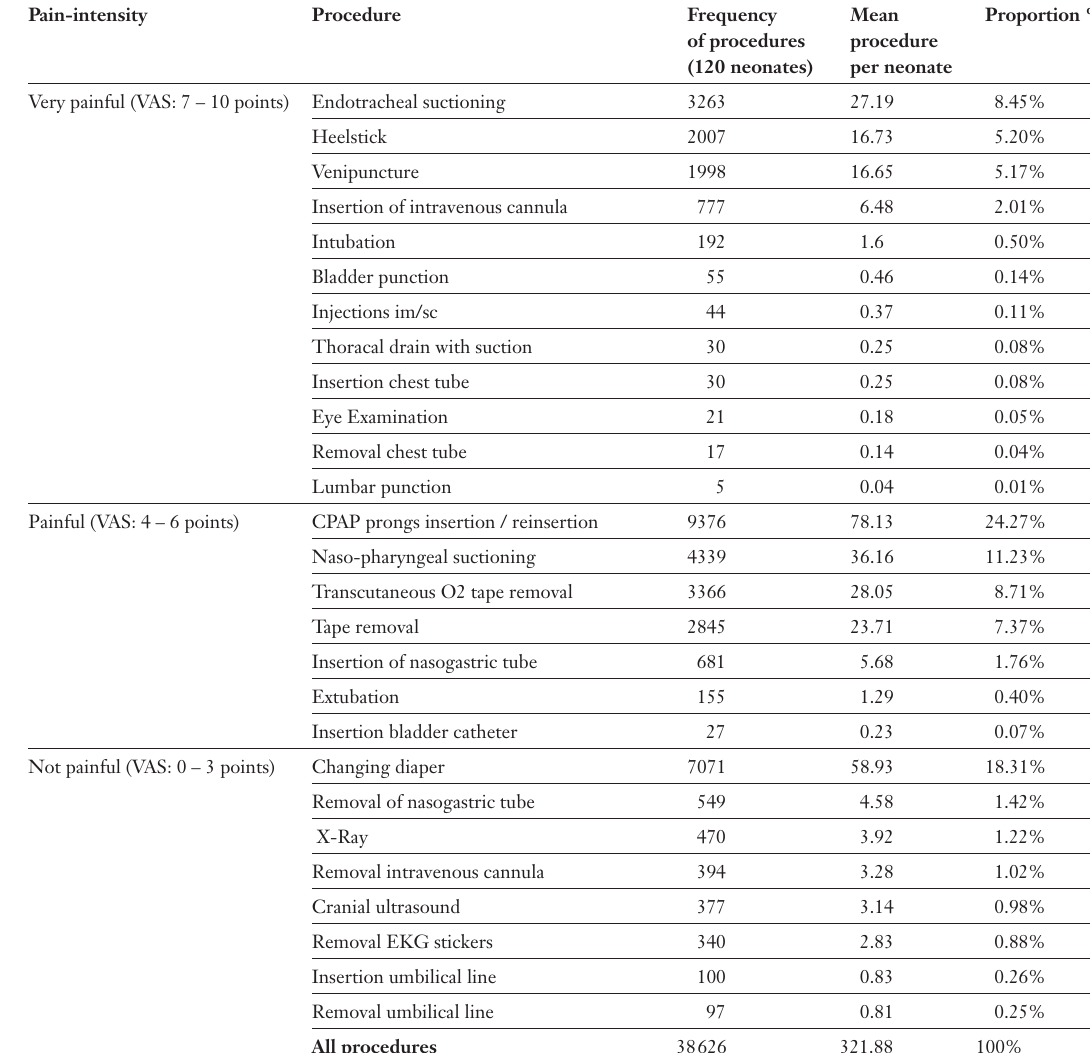
Table 3 Procedures performed in 120 preterm neonates categorised by pain-intensity and